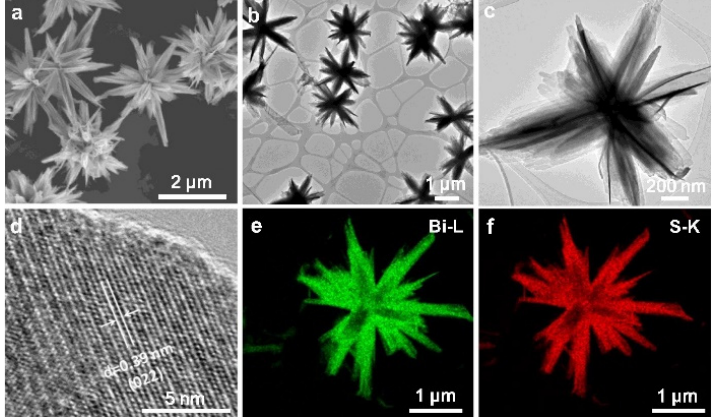
Figure 17. ( a ) SEM and ( b , c ) TEM images with different magnifications of Bi 2 S 3 − 1. ( d ) HRTEM image and ( e , f ) EDS elemental mapping of Bi 2 S 3 − 1.